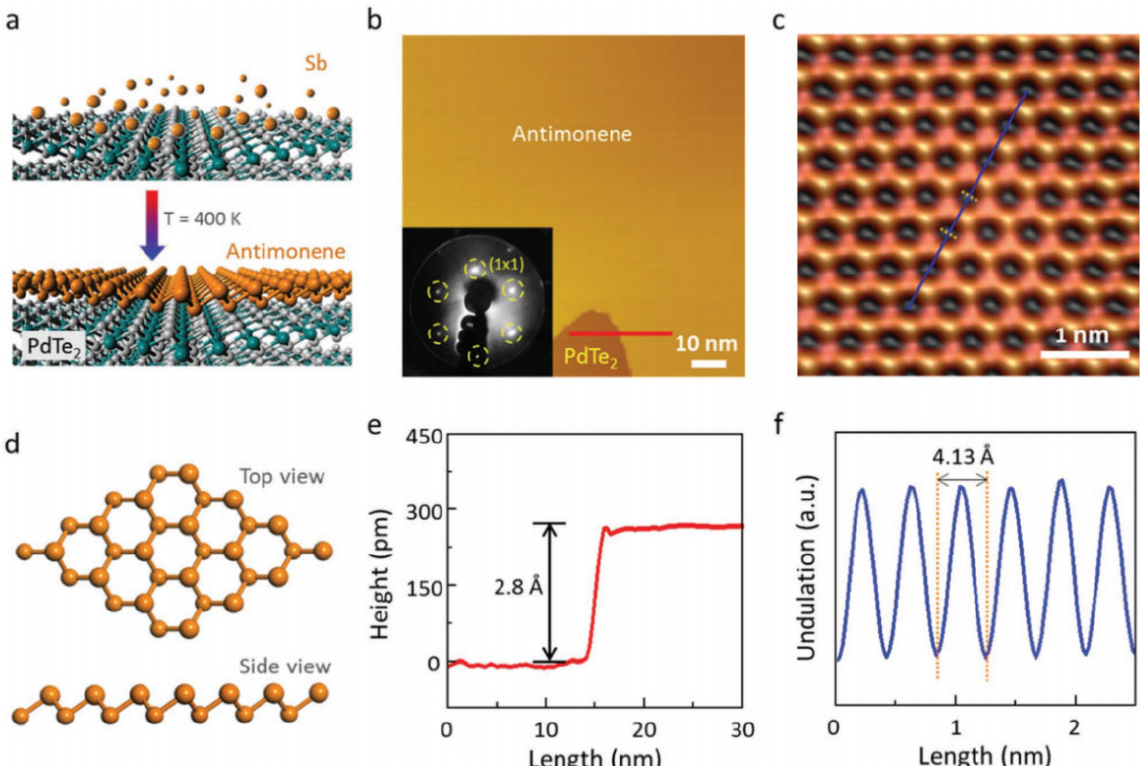
Figure 9. Antimonene formed on PdTe 2 substrate: ( a ) Schematic diagram of fabrication; ( b ) STM topographic map, illustration: LEED pattern of antimonene on PdTe 2 . The six diffraction spots are due to the (1 × 1) structure of antimonene relative to the substrate; ( c ) Single–layer antimonene with atomic resolution STM image, showing graphene–like honeycomb; ( d ) Top view (upper) and side view (lower) of the structure of antimony honeycomb belt buckle; ( e ) The height profile along the middle red line ( b ) shows that the apparent height of the antimonene island is 2.8 Å; ( f ) Line profile corresponding to the blue line in ( c ), revealing periodicity of the antimony lattice (4.13 ± 0.02 Å). Reprinted with permission from Ref. [55]. Copyright 2016, John Wiley and Sons.